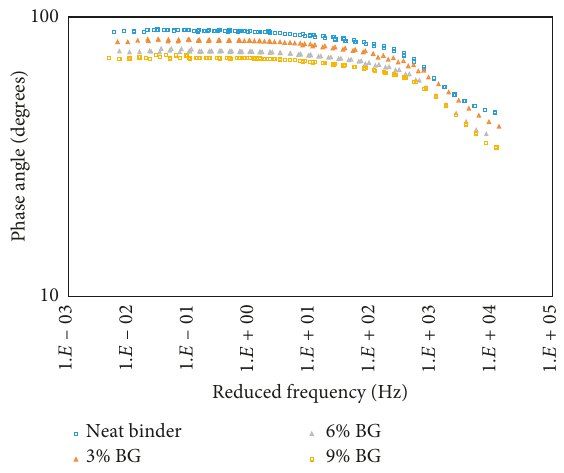
Figure 8: Master curve for δ at 58 °